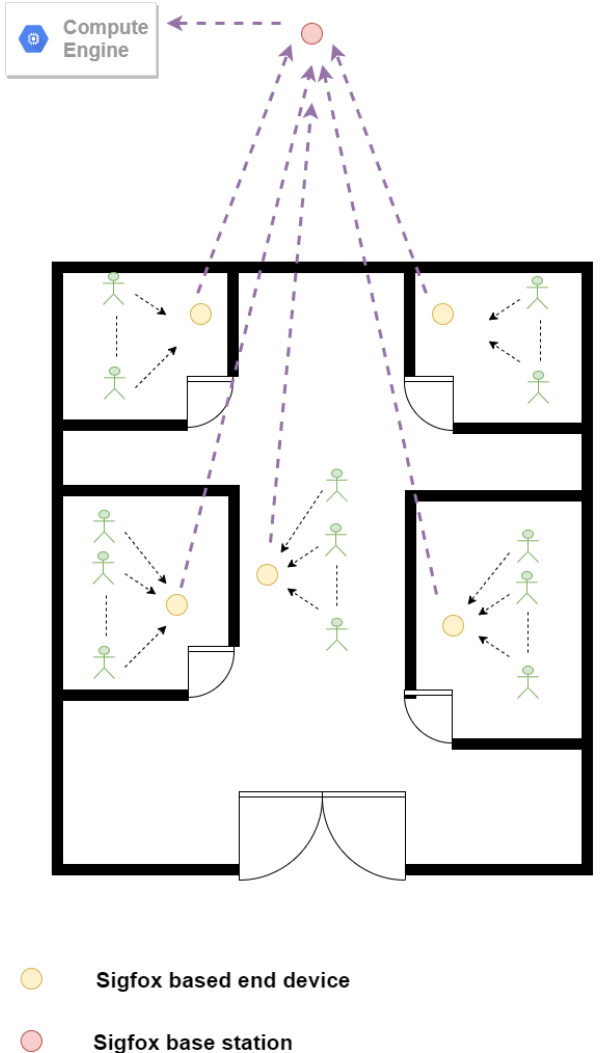
Figure 5. Case study using Sigfox technology for uplink data